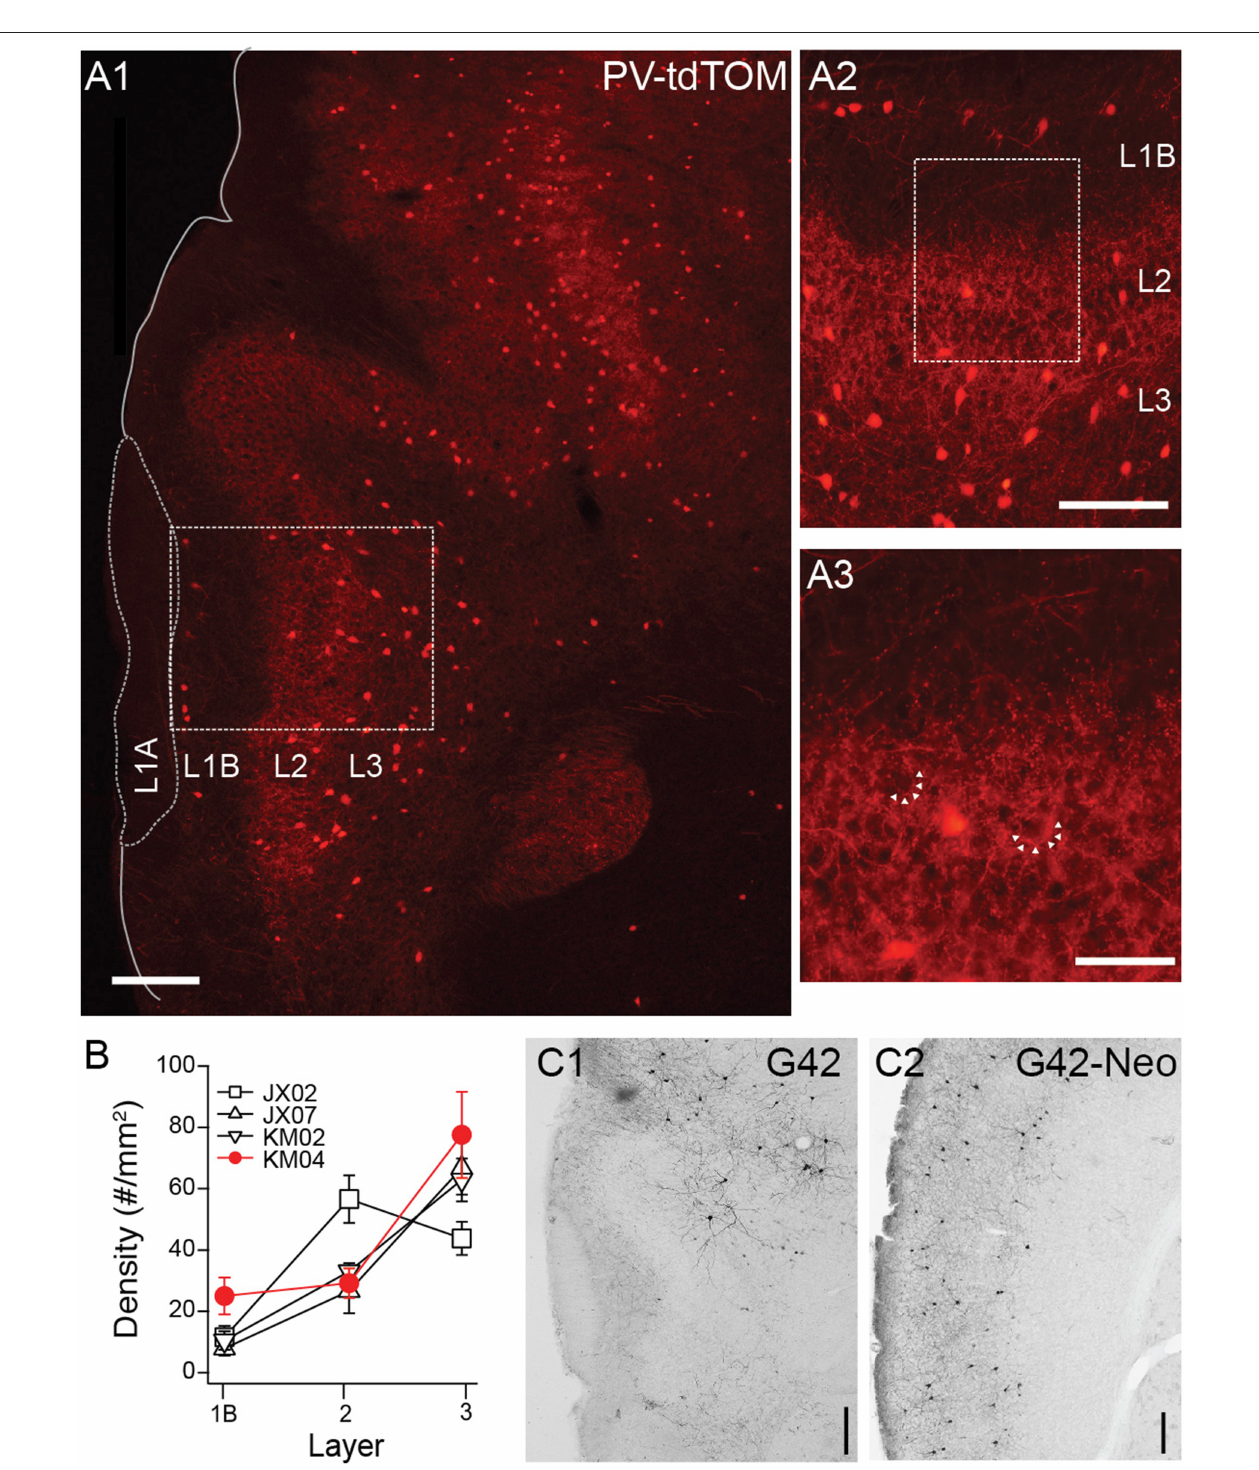
FIGURE 3 | Distributions of PV-cre cells in anterior piriform cortex. (A1) Coronal section from a PV-tdTom mouse (KM04). 4x magnification, Scale bar: 200 µ m. (A2) Enlarged (10x) area of A1 showing a lack tdTom fluorescence in L1B but strong fluorescence in L2. Scale bar: 100 µ m. (A3) Enlarged (20x) area of box shown in (A2) . Note punctate tdTom fluorescence outlining dark voids (arrows) suggestive of basket synapses. Scale bar: 50 µ m. (B) Average density of PV-cells in each layer for four different mice from two different litters (denoted JX, KM). Points shown in red correspond to data from mouse KM04 shown in panels (A1–A3) . (C) Anti-GFP labeling in coronal sections from a G42 mouse (C1) APC (C2) Neocortex (Neo). 4x magnification, Scale bar: 200 µ m.